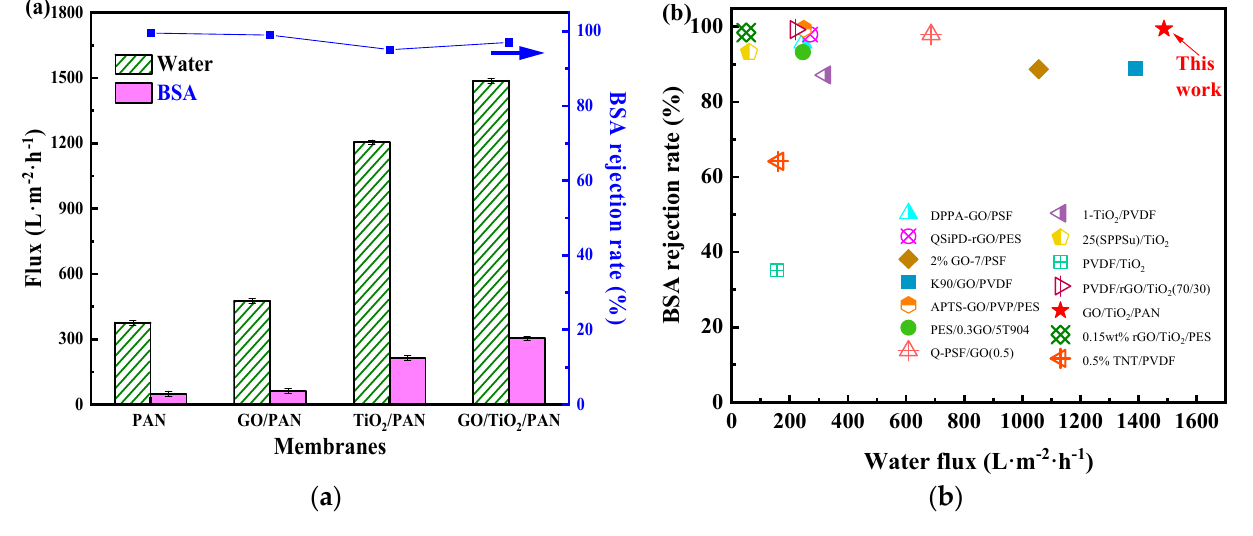
Figure 10. ( a ) Pure water flux and BSA rejection rate of the PAN, GO/PAN, TiO 2 /PAN and GO/TiO 2 /PAN membranes, ( b ) Comparison of the filtration performance in current work with others.